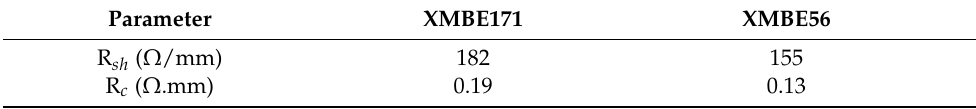
Table 3. Devices comparison on R sh and R c from TLM